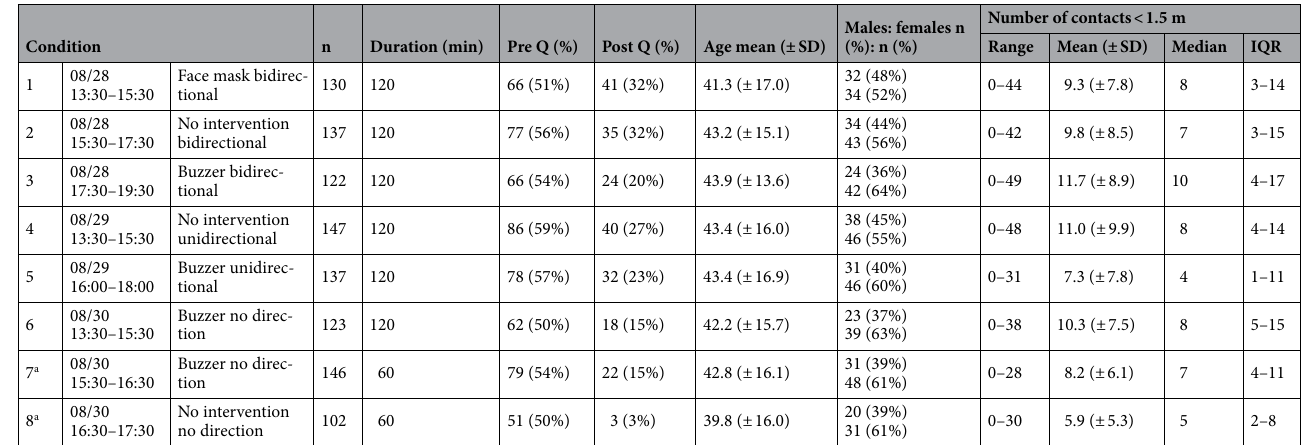
Table 1. Descriptives per condition. Information on age and sex is based only on visitors who completed the pre-questionnaire and provided this information (n = 3 did not wish to disclose their sex). Number of visitors in each condition don’t add to N = 639, as some people stayed for more than one condition. a Condition lasted only 60 min and was excluded from